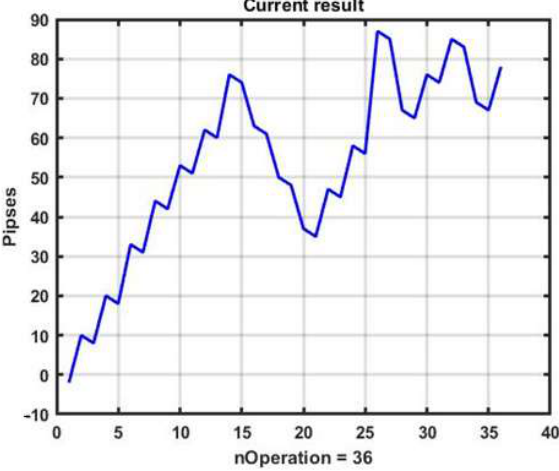
Figure 9. Example CSF implementation with five optimized parameters.